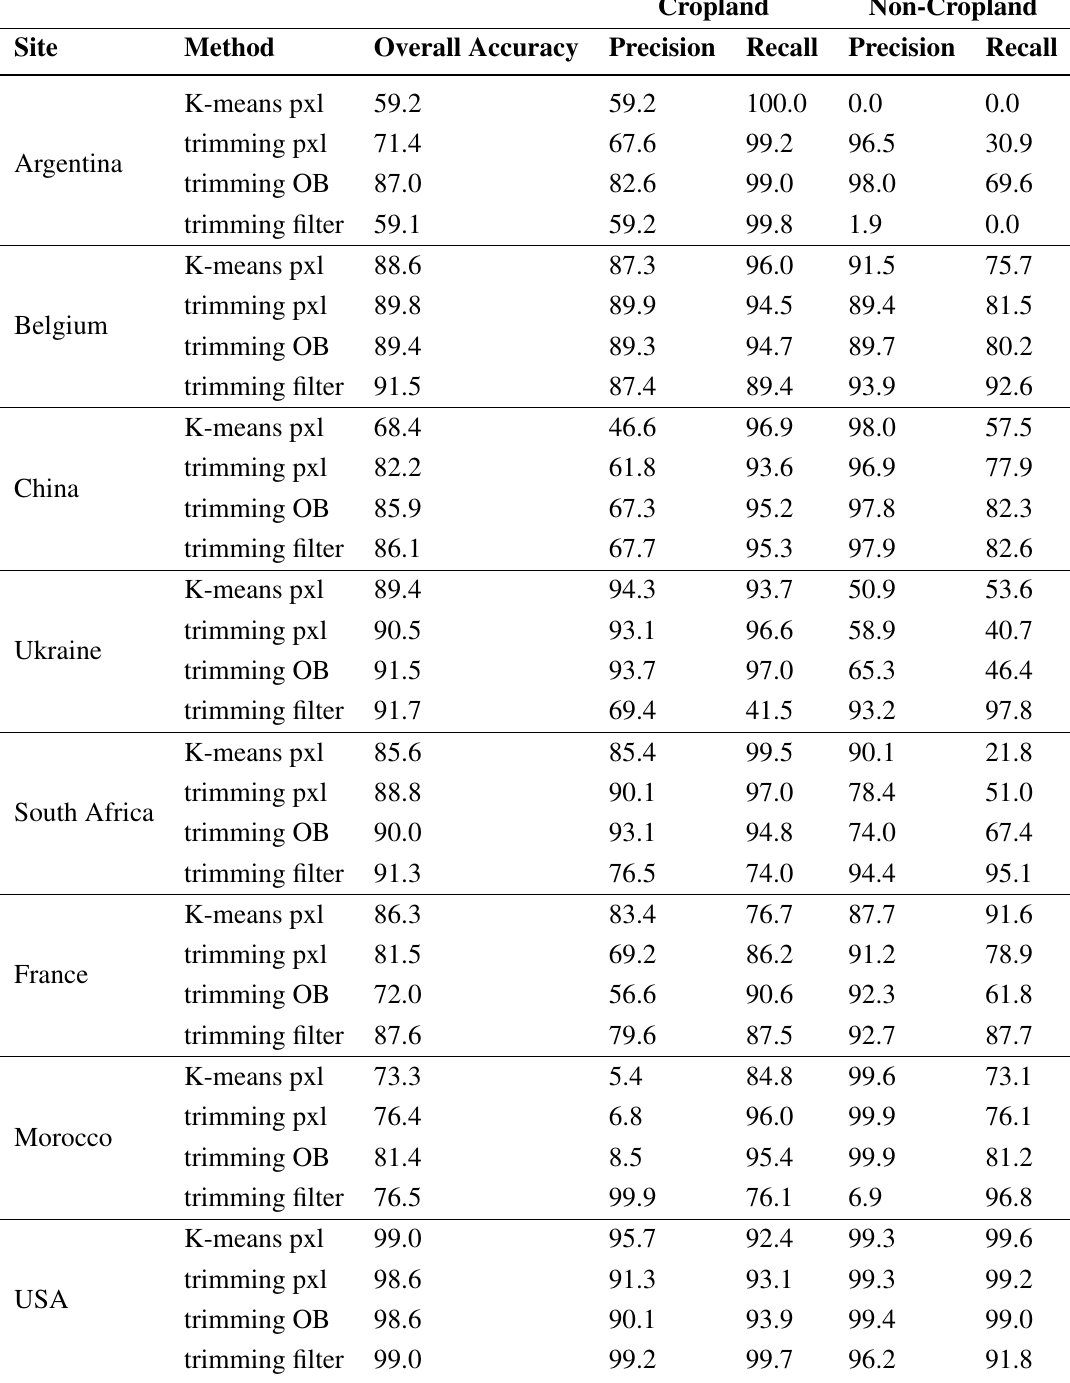
Table 5. Accuracy results for the eight sites obtained by the K-means algorithm at the pixel scale (pxl) and the maximum likelihood classifier with the trimming method at the pixel scale (pxl), at the object-level (OB) or filtered by objects